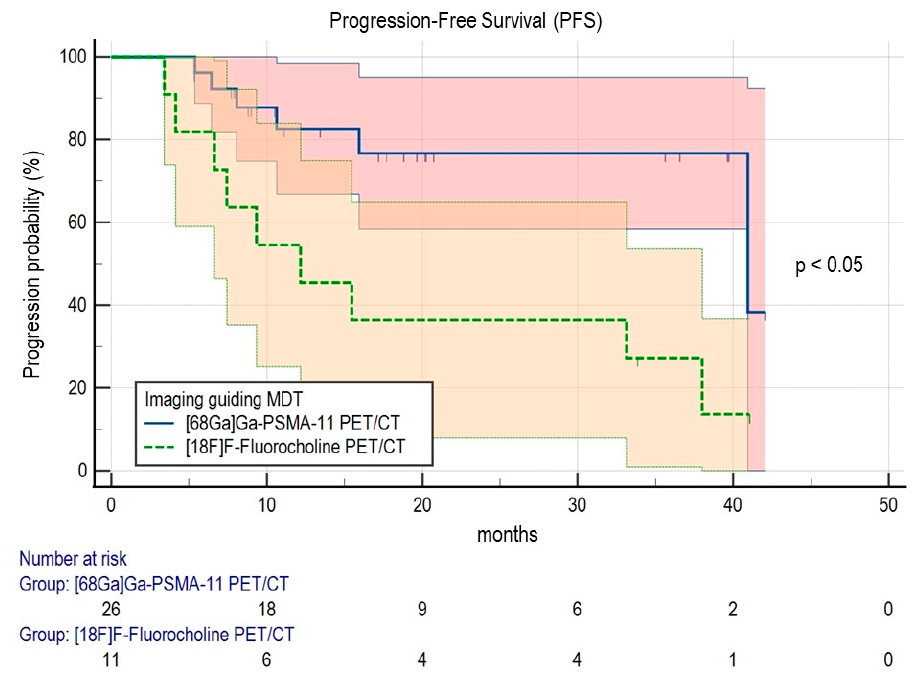
Figure 2. Kaplan-Meier curves for PFS according to the PET/CT radiotracer adopted to guide MDT. The comparison was performed with the Log Rank test. Abbreviations: MDT, metastasis-directed therapy; PET/CT, positron emission tomography/computed tomography; PFS, progression-free survival. Table 2. Prognostic values of clinical and imaging characteristics in the prediction of